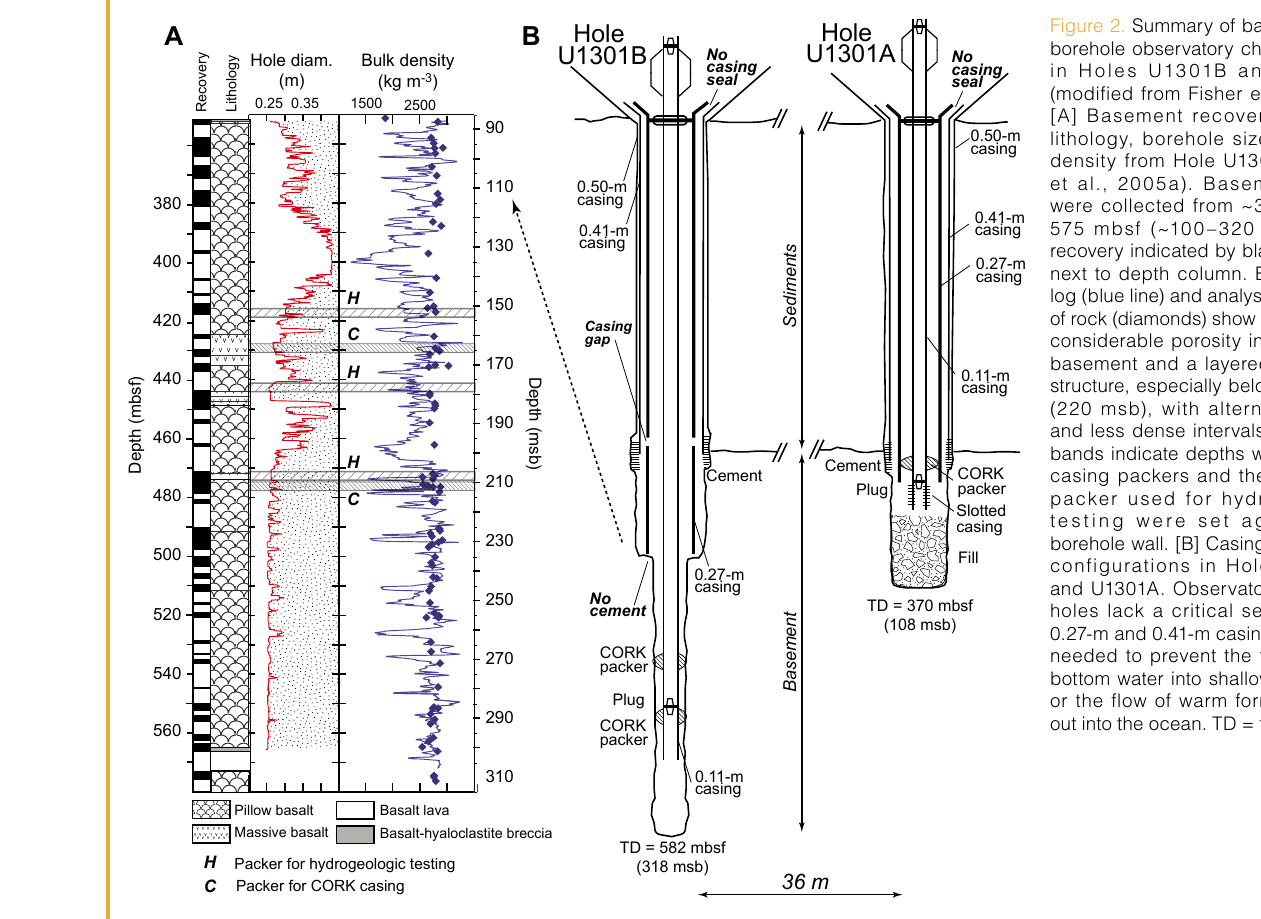
Figure 2. Summary of basement and borehole observatory